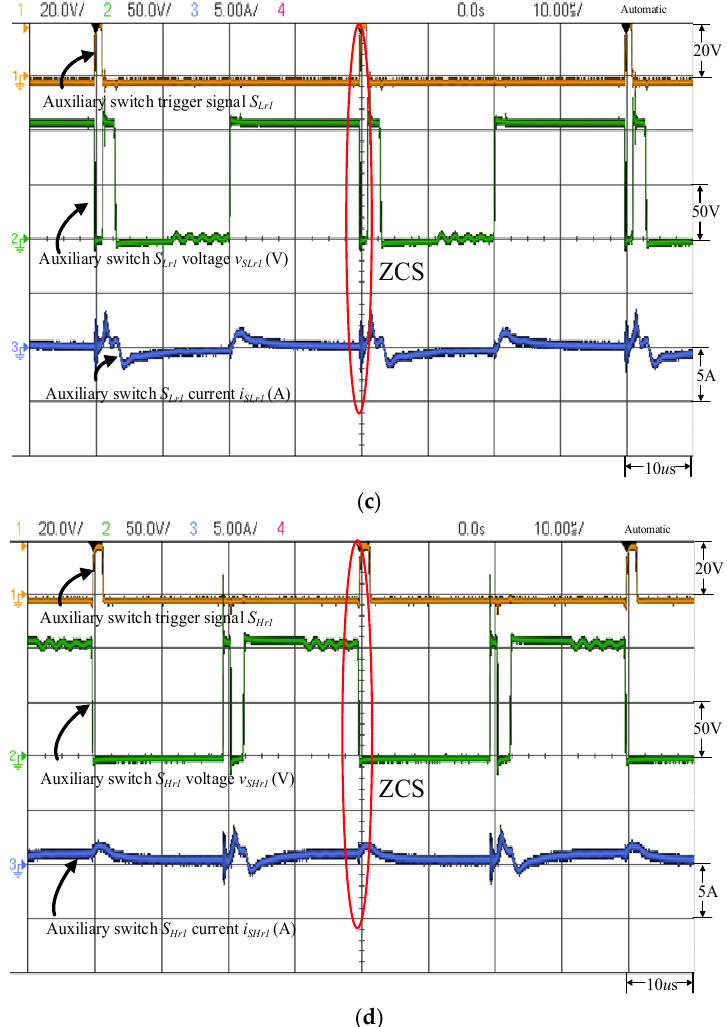
Figure 8. The actual test waveform for boost mode; the load is 300 W for each switch component: ( a ) main switch S L 1 ; ( b ) main switch S H 1 ; ( c ) auxiliary switch S Lr 1 ; ( d ) auxiliary switch S Hr 1.